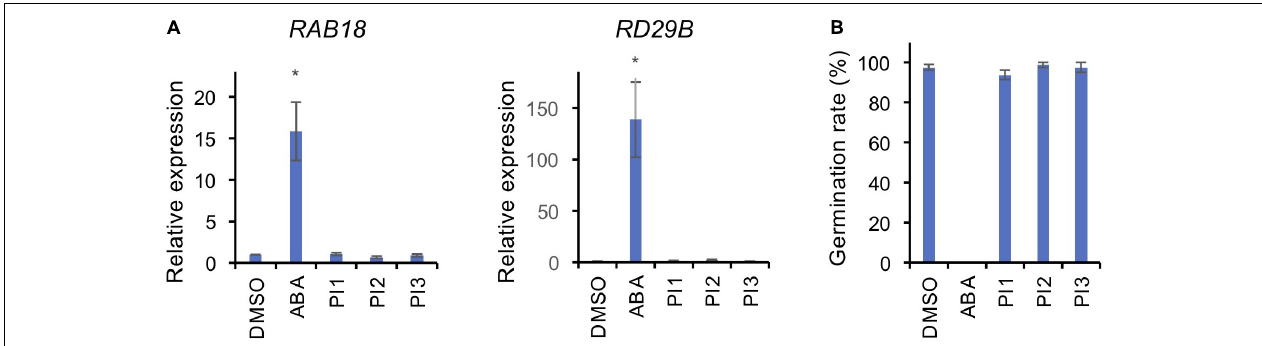
FIGURE 4 | Effects of PIs on ABA-induced gene expression and seed germination. (A) Expression levels of ABA-responsive genes, RAB18 and RD29B , were determined by qRT-PCR in response to ABA and PIs in Arabidopsis seedlings. TUB2 was used as the internal standard. Two-week-old seedlings were treated with 50 µ M ABA or 100 µ M PIs or an equal volume of DMSO under white light for 3 h at 24 ◦ C. Means ± SE ( n = 3; 3 whole seedlings per replicate). Student’s t -test, * P < 0.05. (B) Effects of PIs on Arabidopsis seed germination. Seeds were immersed in water with 50 µ M ABA or 100 µ M PIs or an equal volume of DMSO in the dark for 2 days for vernalization, and 7 days for germination under light. Means ± SE ( n = 4; 20 seeds per replicate).